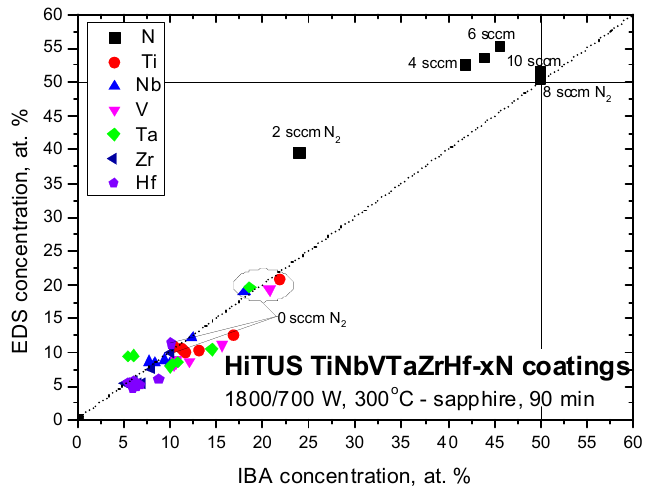
Figure 11. The comparison of the concentrations of TM and nitrogen in the studied reactive HiTUS TiNbVTaZrHf-xN coatings obtained by EDS/SEM and IBA methods. The dotted diagonal line indicates an ideal overlap between both methods.